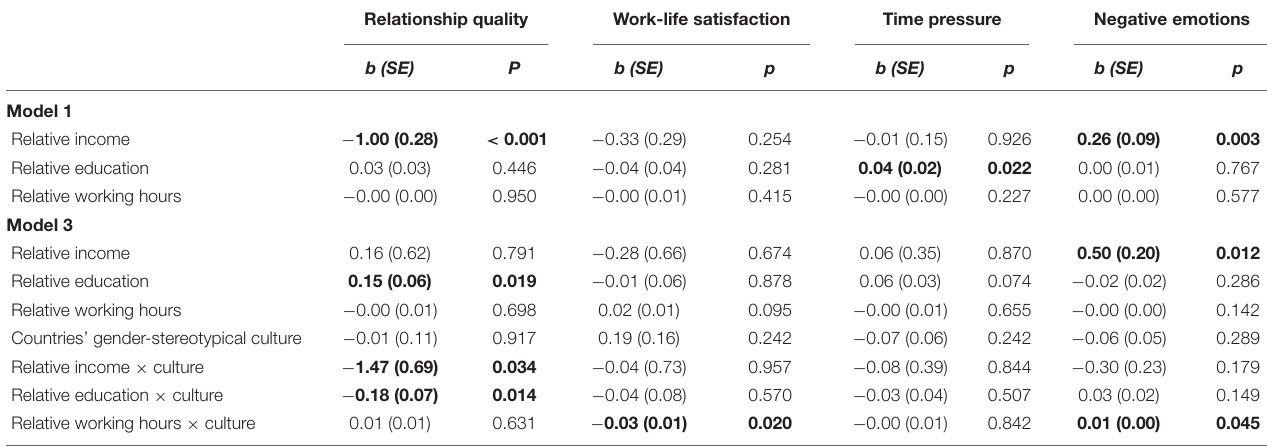
TABLE 4 | Hierarchical linear regression models of main effects of women’s status relative to their partners on dependent variables (model 1) and of main and interaction effects of women’s relative status and culture on dependent variables (model 3). Relationship